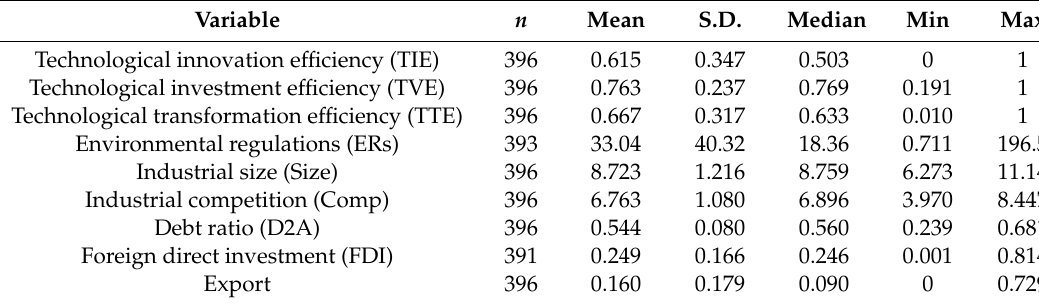
Table 4. Descriptive statistics of all